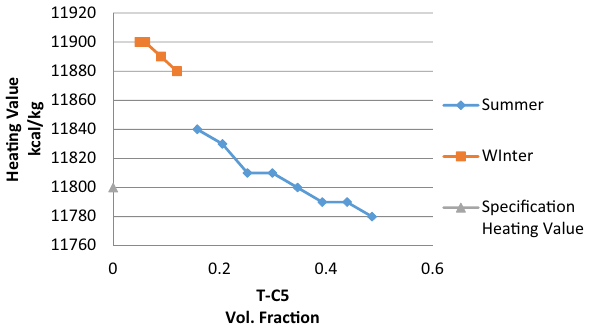
Fig. 26 Effect of adding a mixture of 2,2DMP and i-C5 on LPG